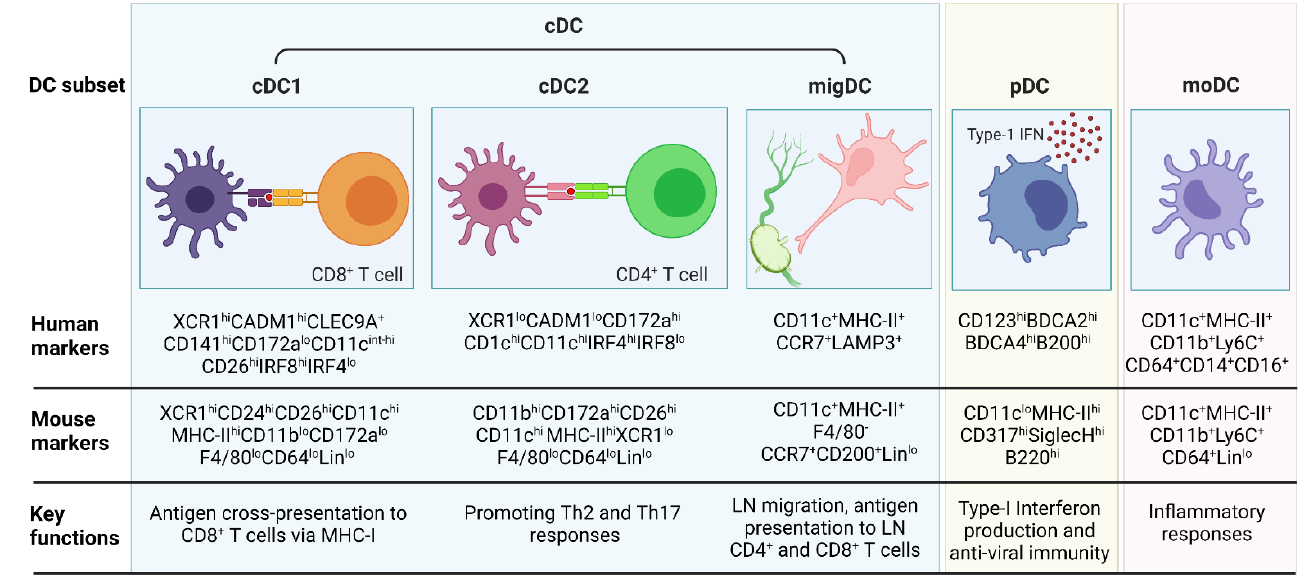
Figure 1. Overview of the different DC subsets, their corresponding mouse and human markers, and key functions. Lin = CD3 + B220 + CD19 + NK1.1 + ; LN, lymph node. Figure created with Biorender.com.